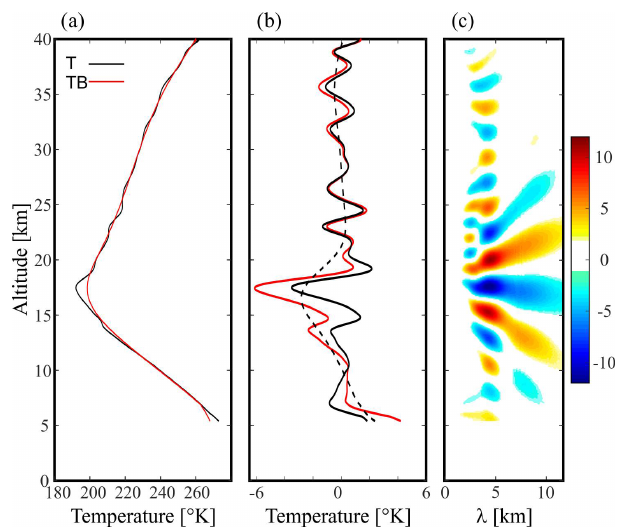
Figure 10. Similar to Fig. 6 but for the RO case study over the Andes